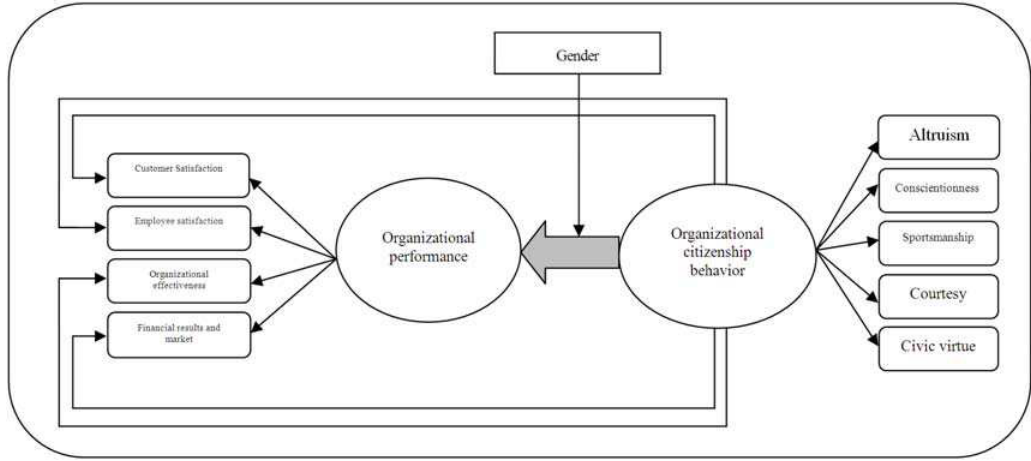
Fig. 1. Research conceptual